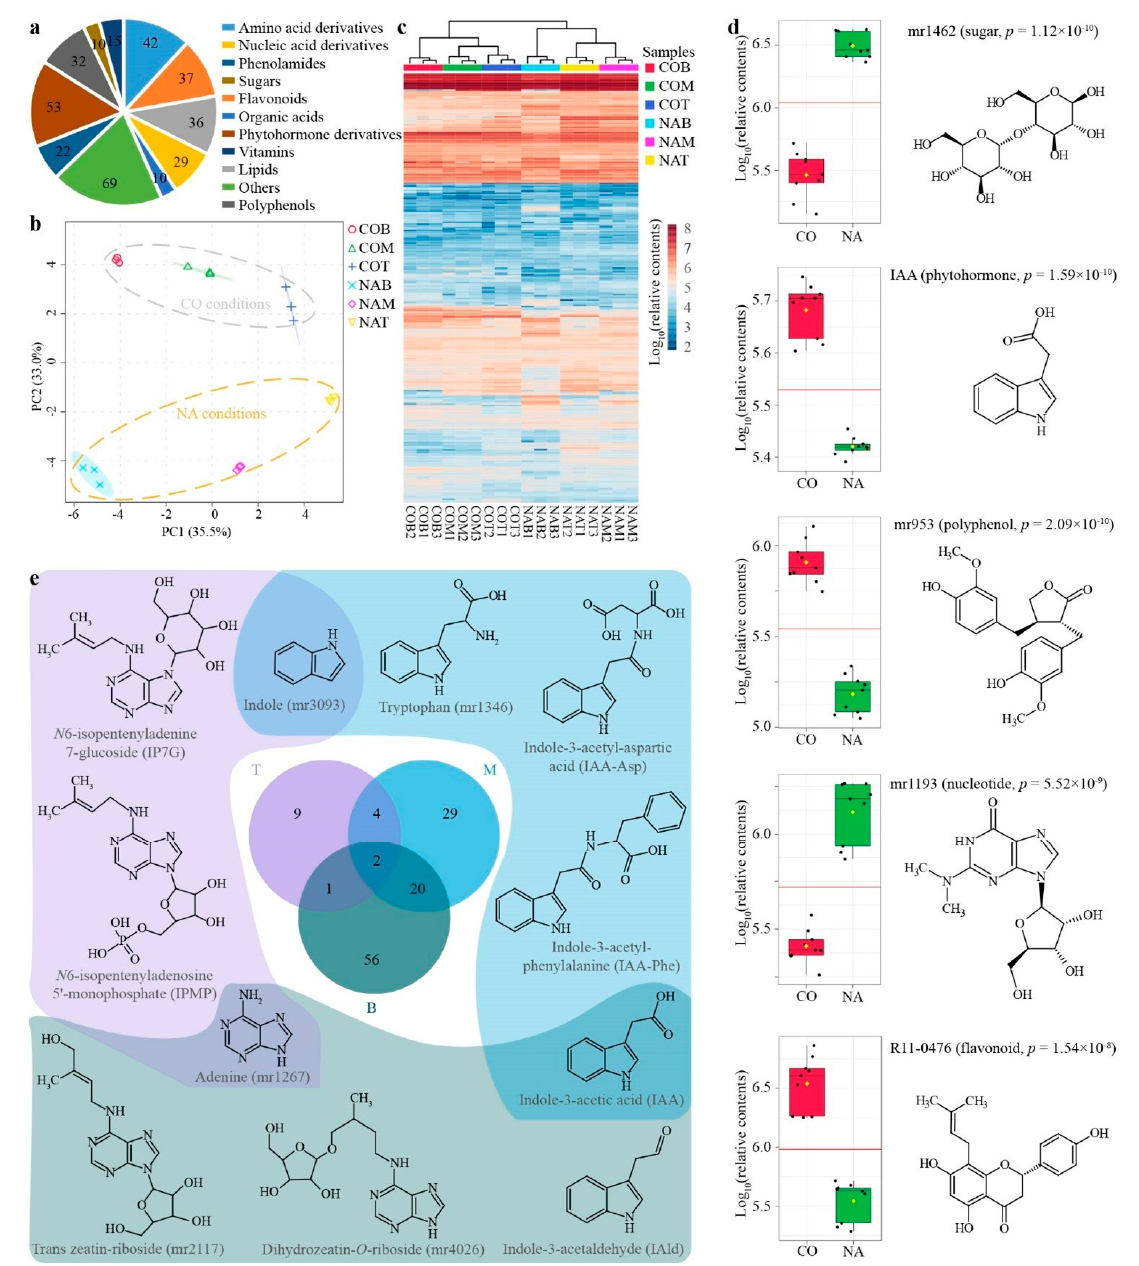
Figure 4. Metabolic profiling of kenaf stems. A total of 355 metabolites from various categories ( a ) have been detected. Principle component analysis of the contents variation could divide the six samples apart ( b ), which were the top (T), middle (M), and bottom (B) kenaf stems under normal (CO) or stress (NA) conditions. For instance, COT indicates the top part of stem (T) under the normal condition (CO). A more detailed contents distribution of these metabolites as a heatmap was also displayed ( c ), in which the kenaf samples could be firstly divided as control (CO) versus NaCl (NA) treatments and then as respective stem parts. The information (relative contents, p − value, classification, and chemical structure) of five mostly enriched metabolites in distinguishing the CO − to − NA conditions were displayed ( d ), wherein Student’s t -test was utilized for statistical analysis. Differentially enriched metabolites among the three stem parts were analyzed ( e ) and exemplified by the chemical structures under respectively colored